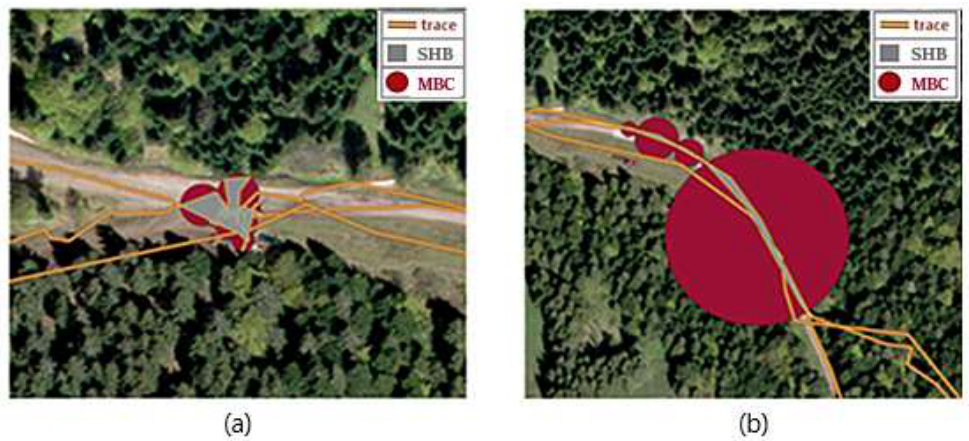
Figure 3. Illustration of the relevance of the elongation criterion for the secondary human behaviour (SHB) approach: ( a ) Computed polygons of a real SHB; ( b ) computed polygons of roundtrip also resulting in a self-intersecting trace.